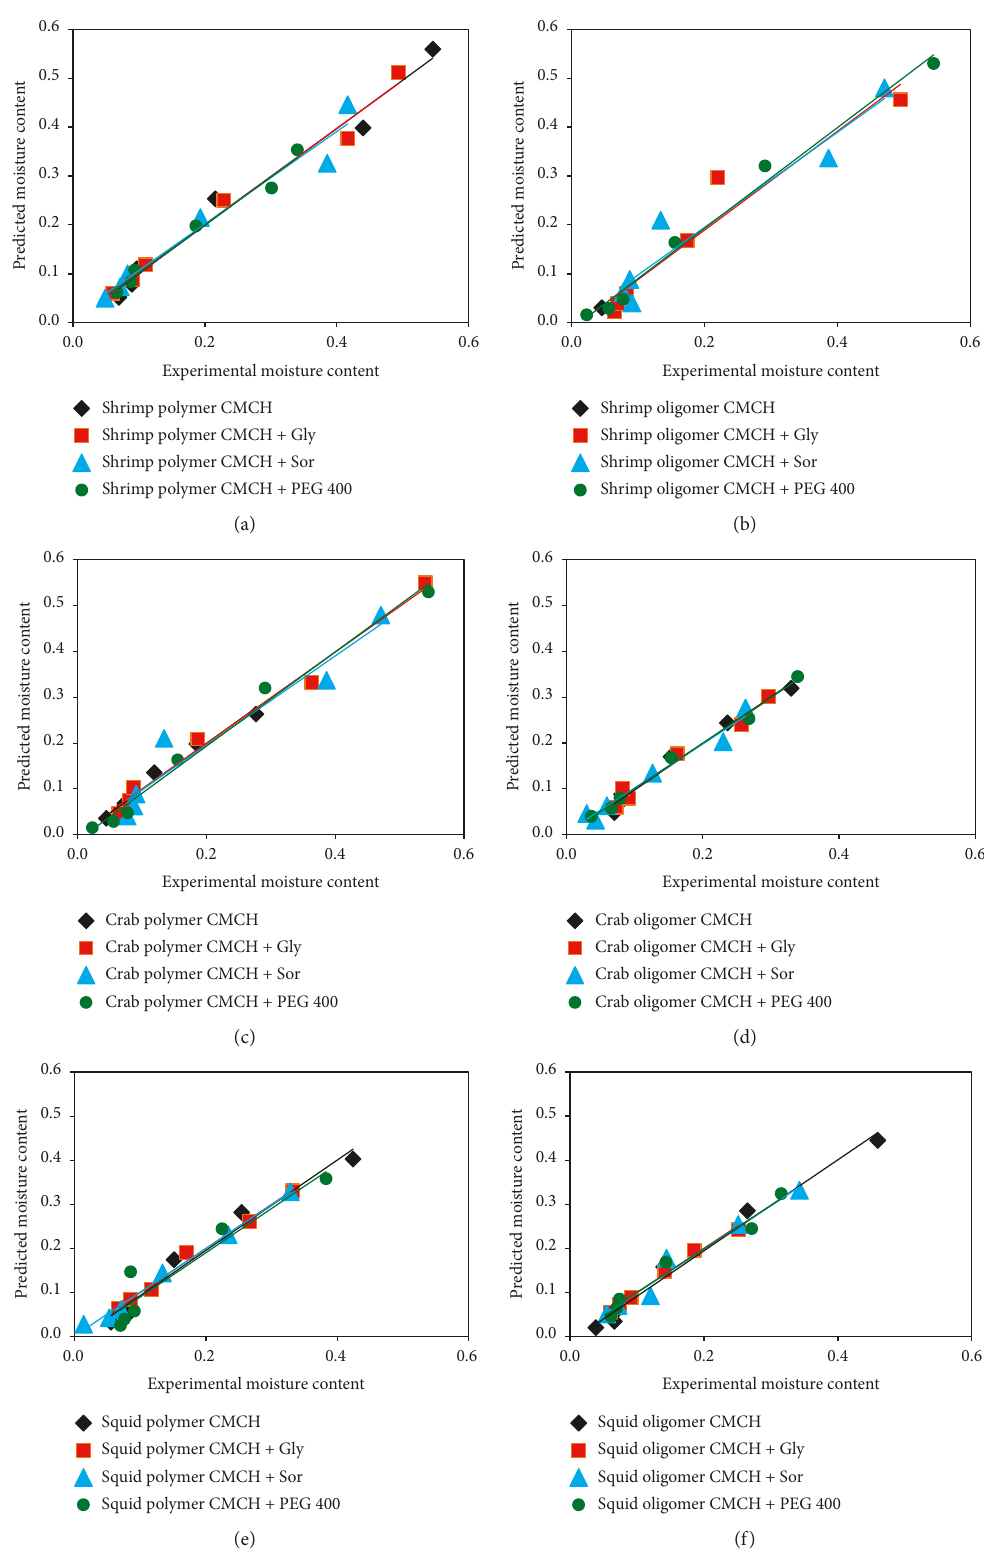
Figure 4: The comparison between the experimental moisture content values and those predicted for all the CMCH films from the Caurie model: shrimp polymer CMCH films (a); shrimp oligomer CMCH films (b); crab polymer CMCH films (c); crab oligomer CMCH films (d); squid polymer CMCH films (e); squid oligomer CMCH films